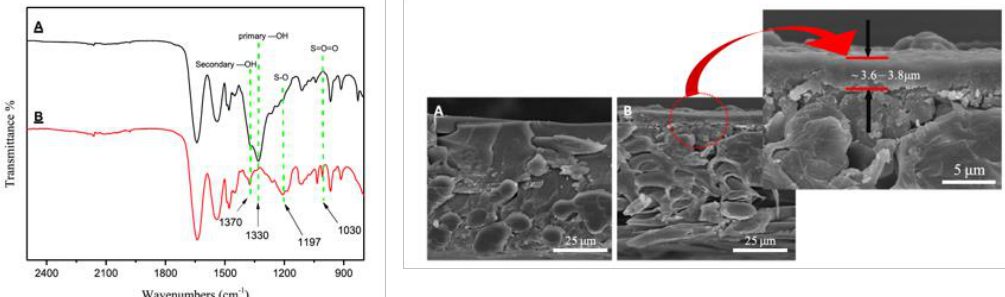
Figure 10. FTIR spectra ( left ) of the homogeneous unmodified AEM (A) and modified AEM (B). Cross-sectional SEM micrographs ( right ) of the unmodified (A) and modified (B) AEM. Reproduced with permission from [42].